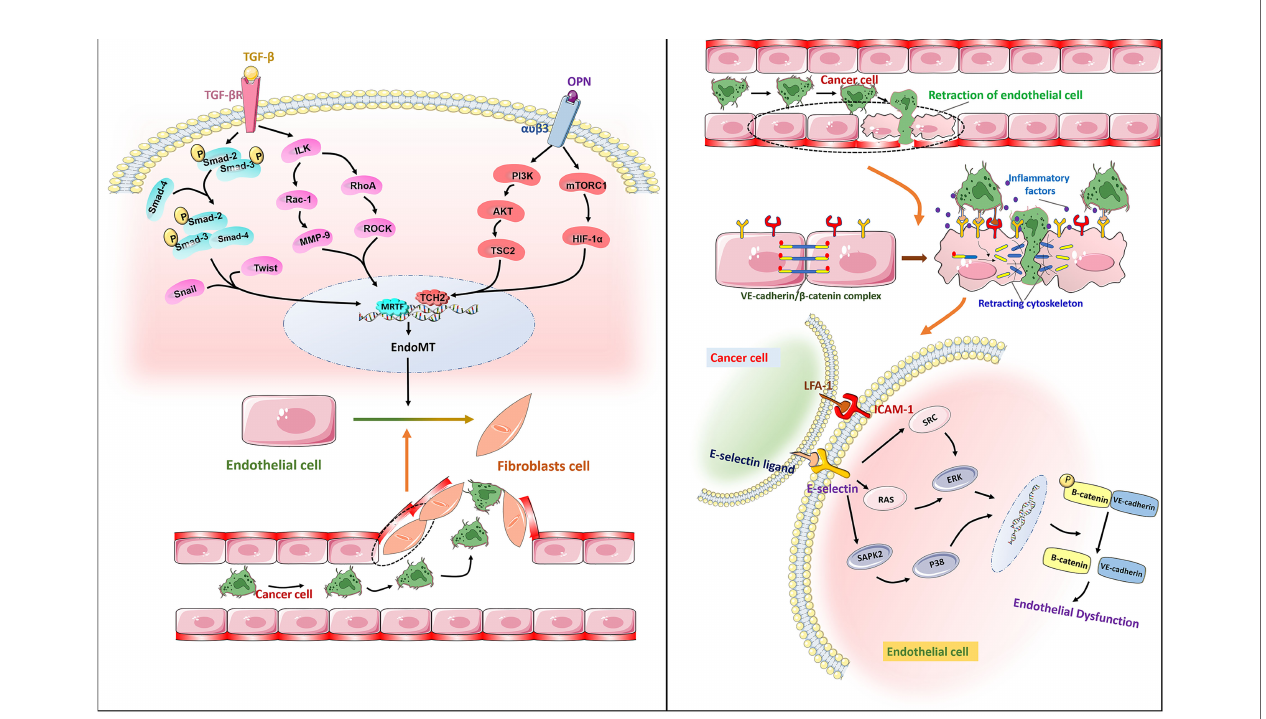
FIGURE 4 | Right: Free TGF- b binds to receptors on the surface of ECs membranes, phosphorylates Smad2 and Smad3, then binds to Smad4, enters the nucleus, and binds to Snail, Twist and other transcription factors to initiate EndoMT by promoting transcription of mesenchymal markers and reducing transcription of endothelial markers. It leads to endothelial dysfunction and promotes the transendothelial migration of cancer cells. Osteopontin (OPN) interacts with a variety of integrins. The combination of OPN and a V b 3 activates PI3K/AKT and mTORC1 pathways and promotes the metastasis of cancer cells.Left: The adhesion molecule ICAM-1 binds to e-selectin through ligand receptor, which enables tumor cells to bind to endothelial cells. The dissociation of the VE-cadherin/ b -catenin complex is associated with endothelial barrier dysfunction. E-selectin regulates the transendothelial migration of cancer cells by activating the ERK and P38 signaling pathways and mediating the dissociation of the VE-cadherin/ b -catenin